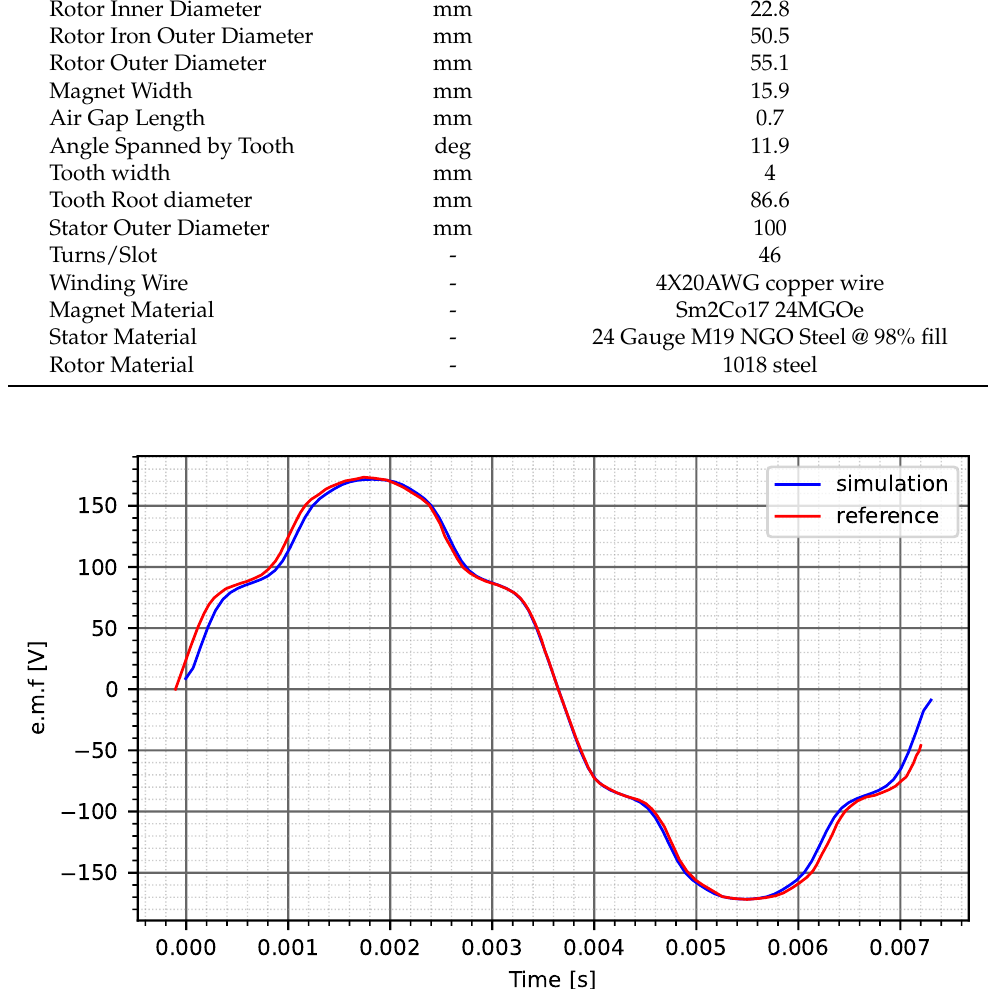
Figure 6. Simulated and benchmark line-to-line voltage